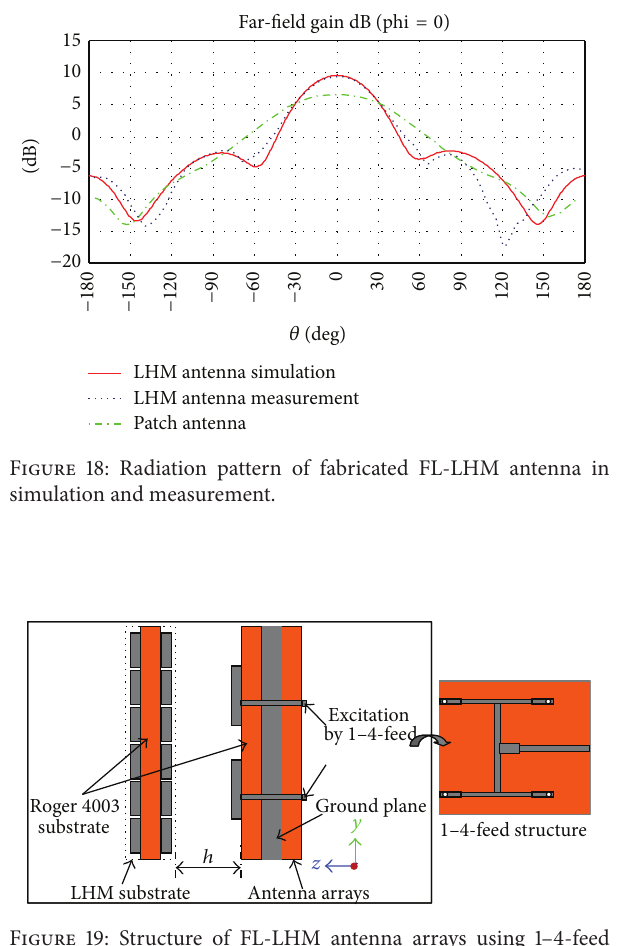
(Figure 21) while the gain is improved to 15.3 dBi and 15.4 dBi (Figure 22) in simulation and measurement,